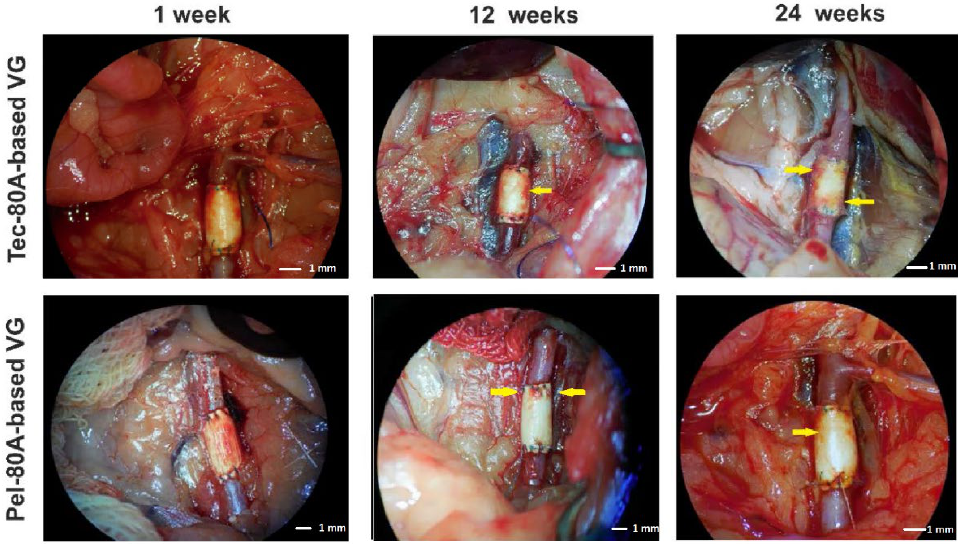
Figure 1. The vascular graft (VG) view during explantation at different points of observation (Carl Zeiss OPMI Pico surgical microscope). The arrows demonstrate the ingrowth of tissues from the outer VG